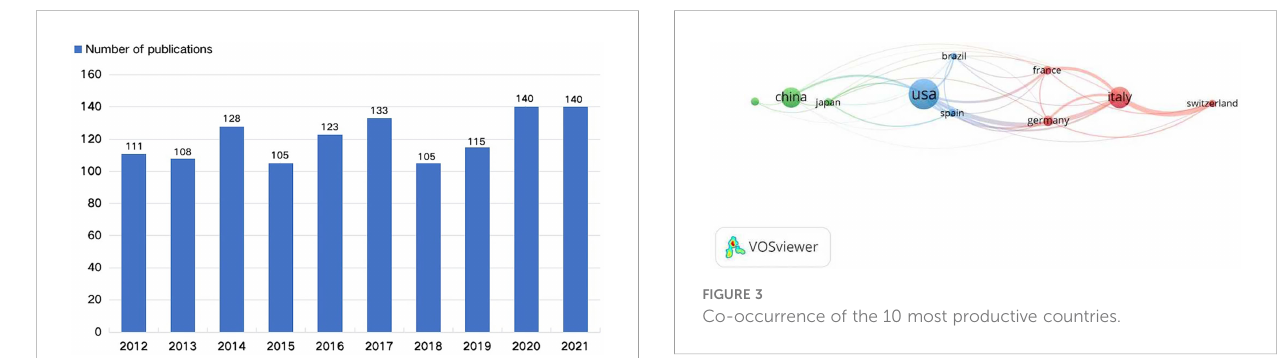
FIGURE 2 Time trend of the publications on MTC.